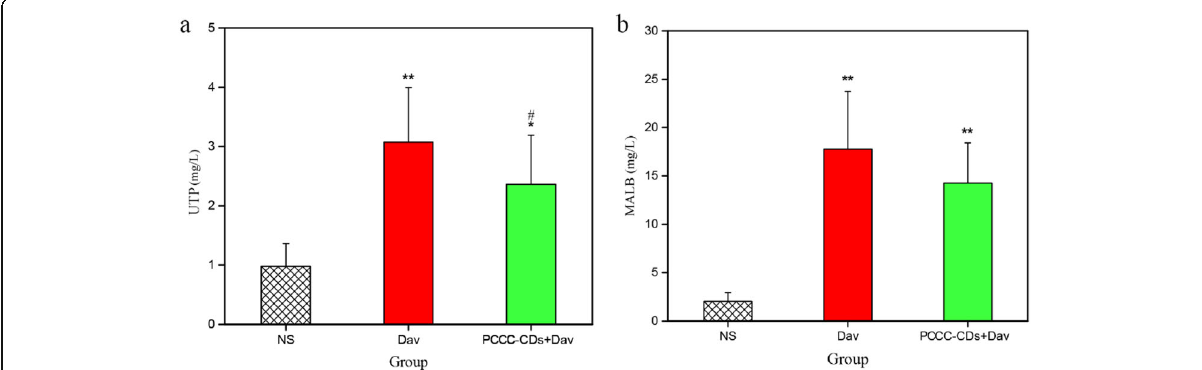
Fig. 5 Effects of Phellodendri Chinensis Cortex Carbonisata-carbon dots (PCCC-CDs) on urinary total protein (UTP) and microalbuminuria (MALB) in the urine. a UTP and b MALB. Mice were treated with normal saline (NS), D.acutus venom (Dav, 1 mg/kg) and PCCC-CDs (4 mg/kg) + Dav (1 mg/kg). Data are represented as mean ± SD of six animals of each group. * p < 0.05 and ** p < 0.01 compared with control group treated with